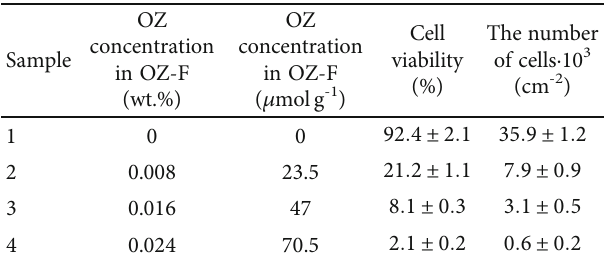
Figure 8: Release pro fi les (kinetic curves) of OZ-F: (a) OZ-F, 0.008% of OZ; (b) OZ-F, 0.016% of OZ; (c) OZ-F, 0.024% of OZ. Table 3: The cell viability ( fi